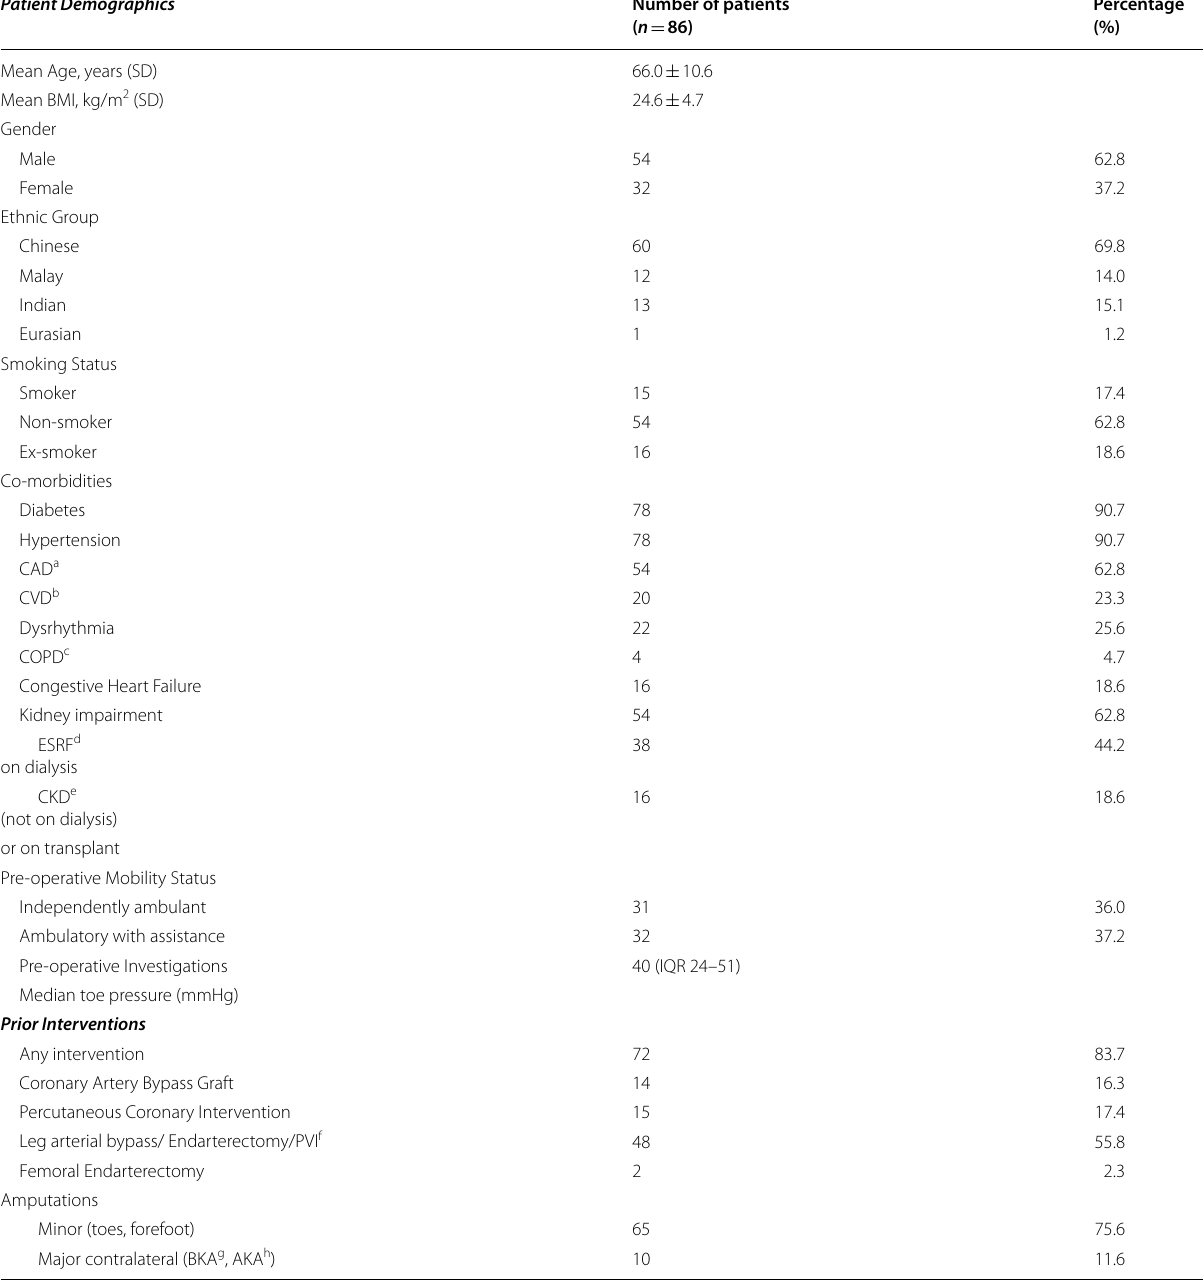
Table 1 Patient Demographics and Prior